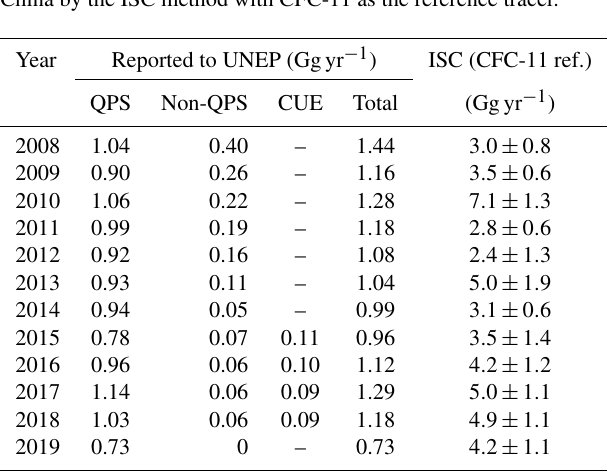
Table 2. Bottom-up and top-down emissions of CH 3 Br from 2008 to 2019 as presented in Fig. 9. The bottom-up emissions are the sum of QPS, non-QPS, and CUE emissions that are converted by emission factors (65% for non-QPS and for the QPS) from con- sumption as reported to UNEP for all of China (data available at the Ozone Secretariat website, http://ozone.unep.org, last access: 15 April 2022). The top-down emissions were derived for eastern China by the ISC method with CFC-11 as the reference